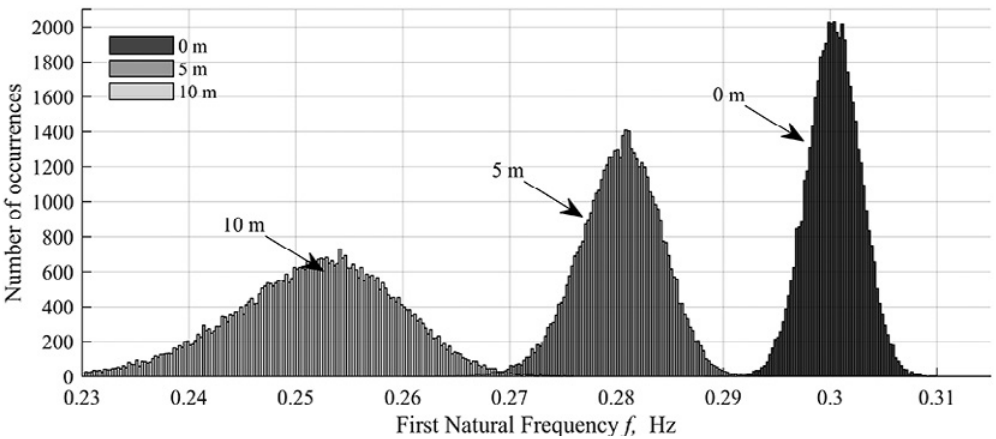
Figure 4. Distribution of Natural Frequency values when soil uncertainty is